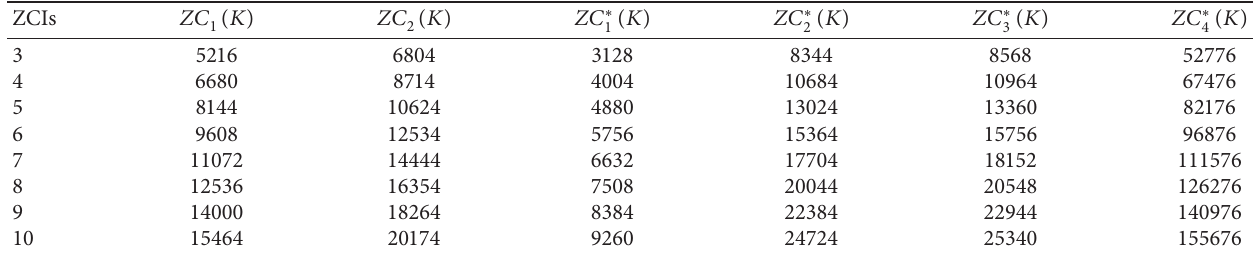
Table 16: Numerical table for indicated ZCIs of network K on dimensions 3 ≤ n ≤